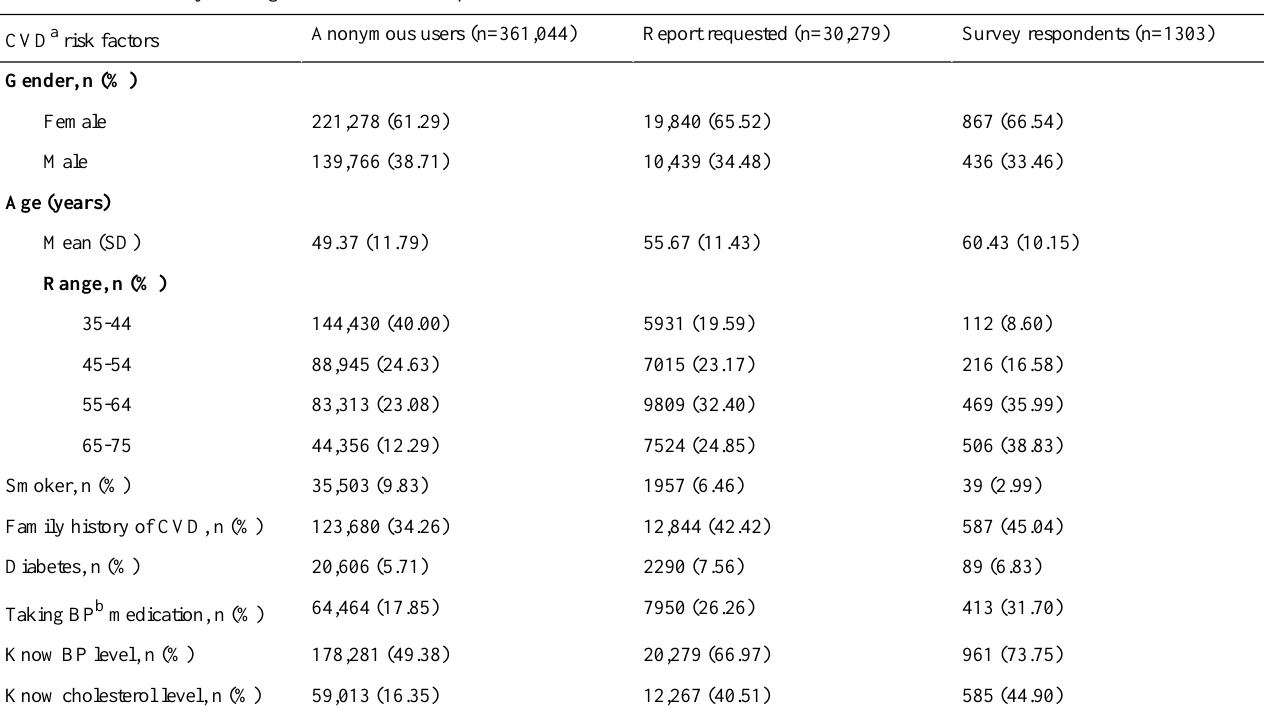
Table 1. Risk factors by heart age calculator user